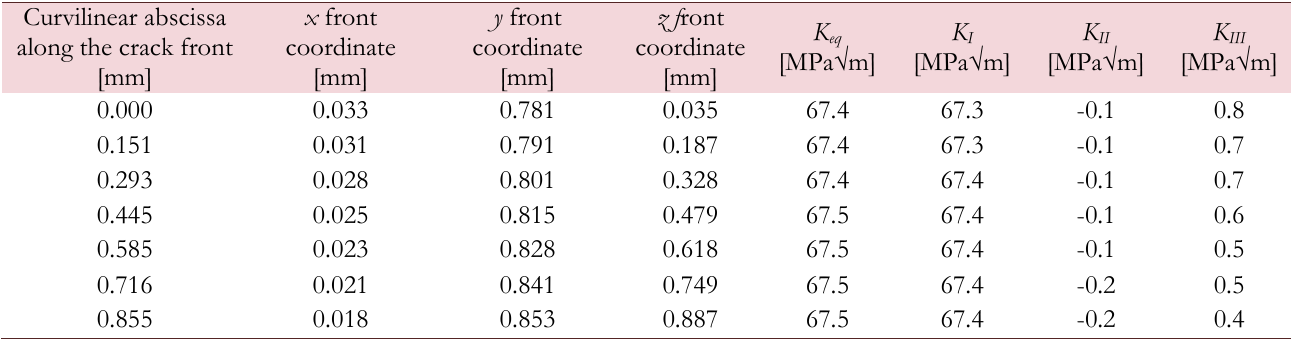
Table 2: Values for K eq , K I , K II , and K III in the 16 th crack growth step.